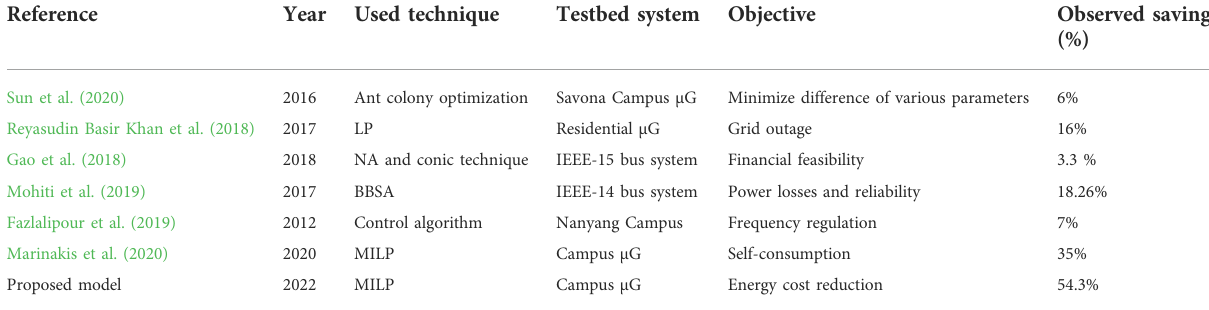
TABLE 6 Comparison of the proposed method with existing